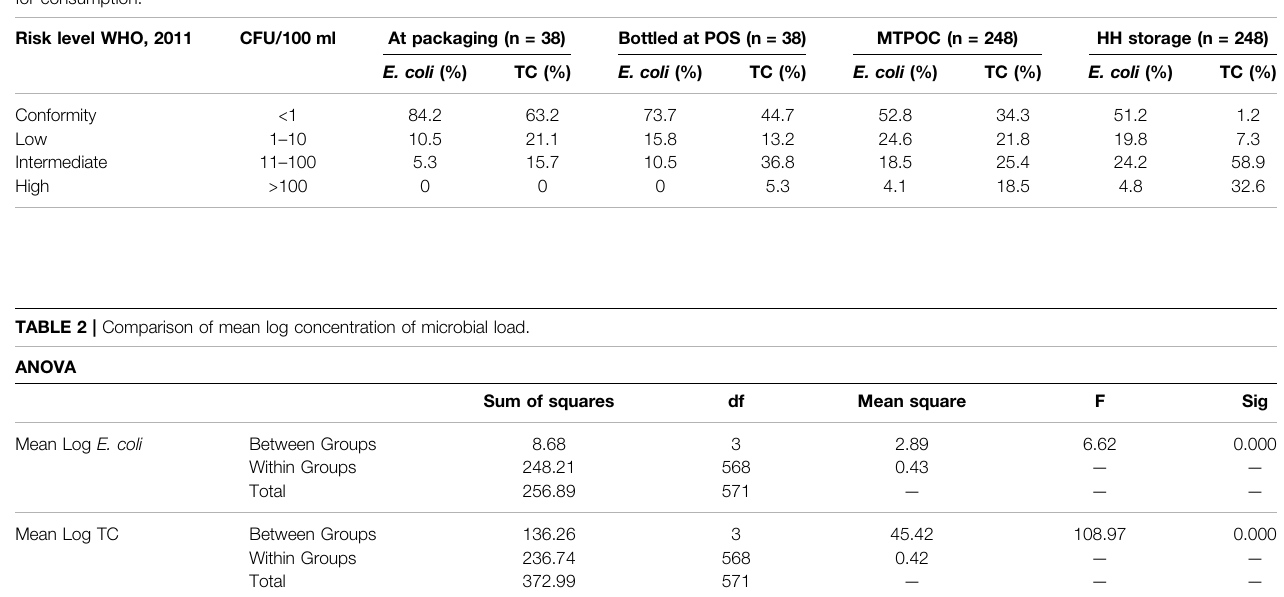
Frontiers in Environmental Science |